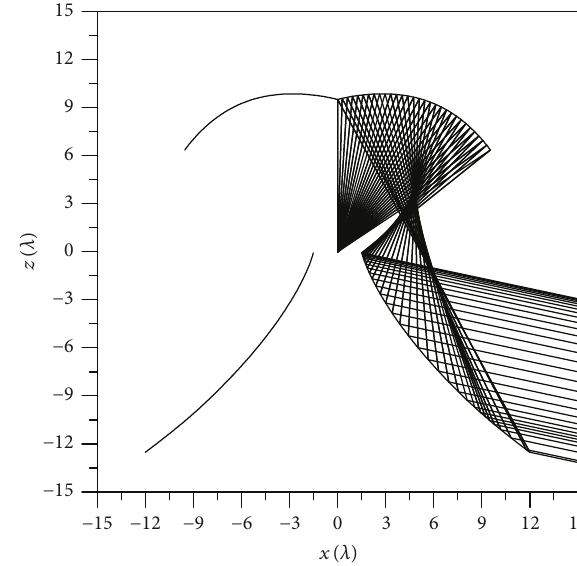
Figure 14: Generatrices and ray tracing of the shaped ADE antenna ′ ). ( − 30 dB attenuation at x U